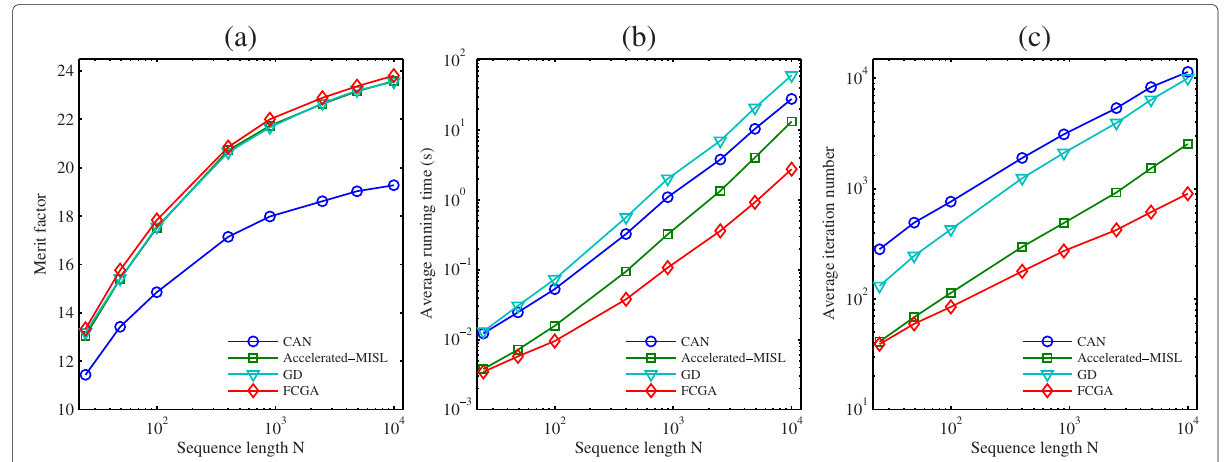
Fig. 5 a – c The performance metrics of different algorithms initialized by random